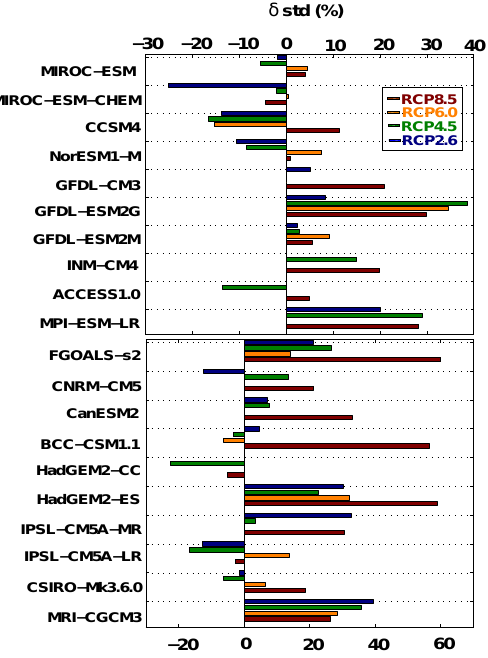
Fig. 10. The percentage change of standard deviation (STD) dur- ing the second half of 21st century to the standard deviation dur- ing the first half of the 20th century under RCP-8.5 (red), RCP-6.0 (orange), RCP-4.5 (green)and RCP-2.6 (blue) for all models under consideration. All values greater than 0 show an increase in variabil- (cid:16) STD (cid:17) · 100 − 100. 2050 − 2100 ity. The percentage change is given as STD 1900 − 1950 The upper and lower panels are separated as in Figs. 6 and